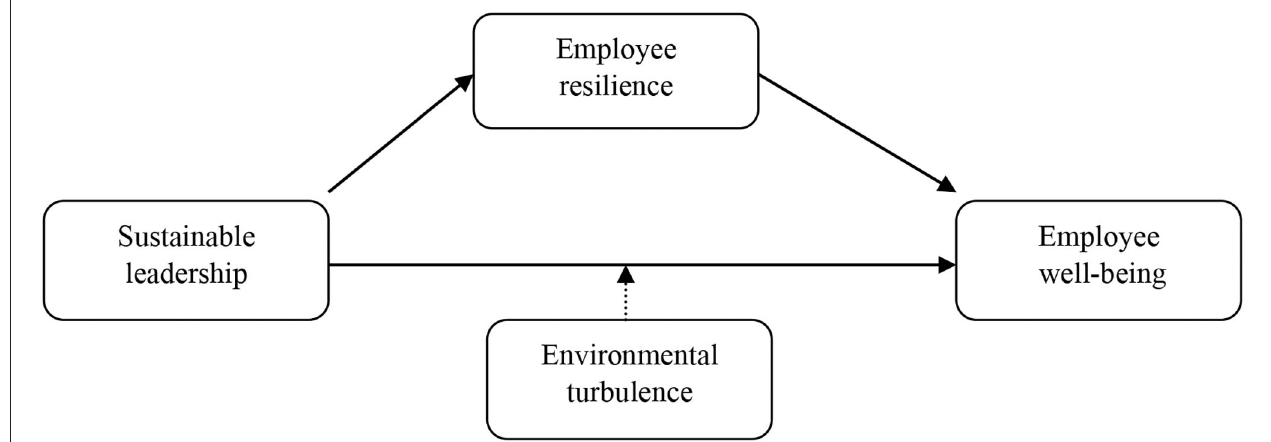
FIGURE 1 | Research